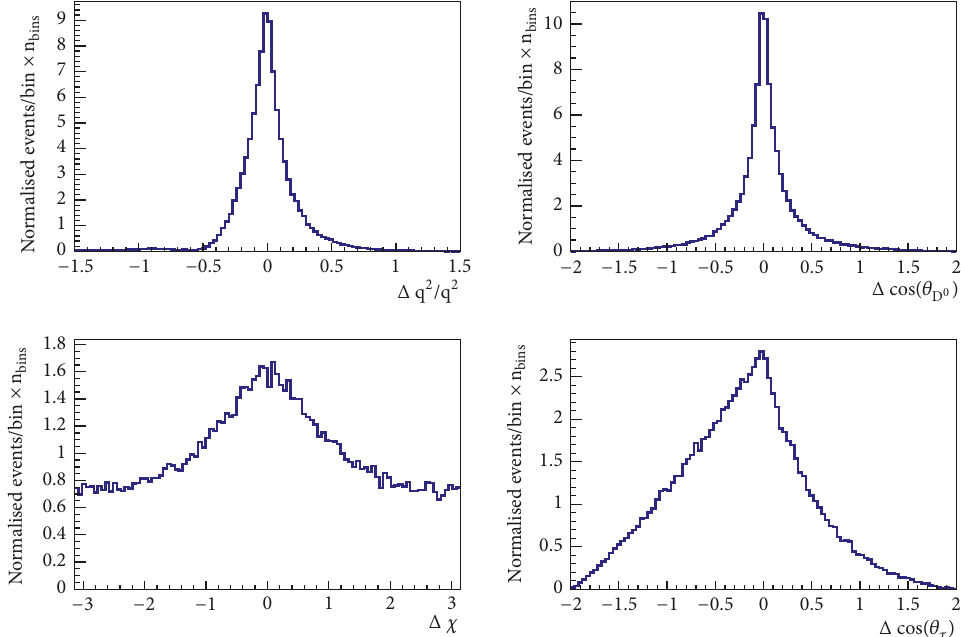
Figure 6: Resolution on the phase space variables for 𝐵 󳨀→ 𝐷 ∗+ 𝜏 − (󳨀→ 𝜋 + 𝜋 − 𝜋 − ] 𝜏 ) ] 𝜏 decays, obtained with full reconstruction algorithm.